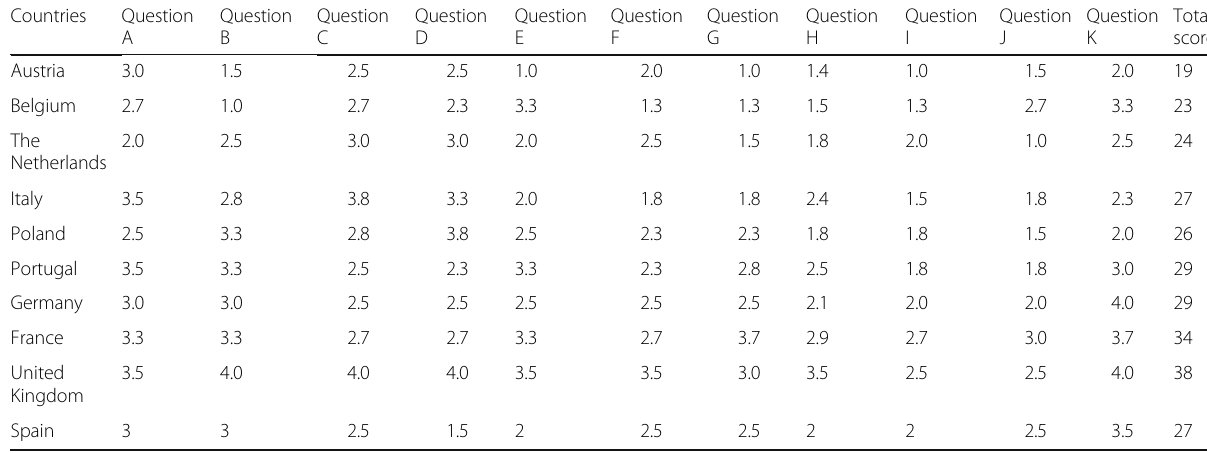
Table 4 Health equity governance at national level Countries